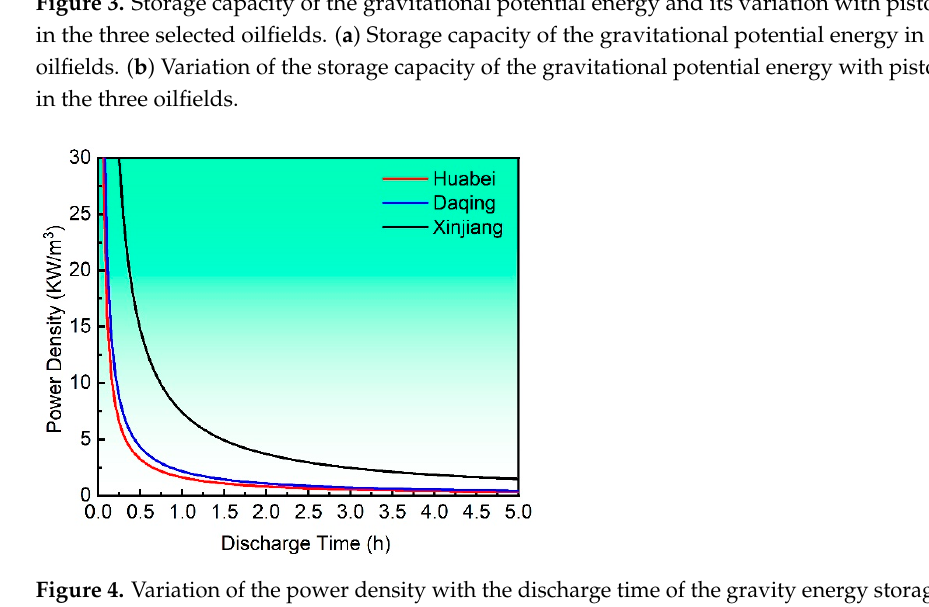
Figure 4. Variation of the power density with the discharge time of the gravity energy storage sys- tem in the three major oilfields.